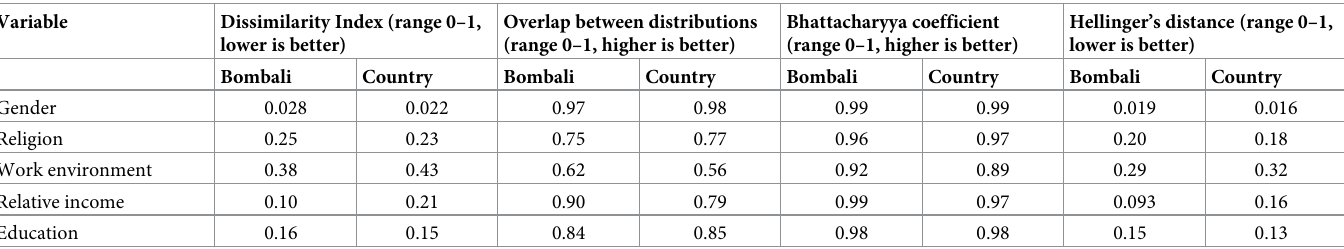
Table 4. Results of marginal distributions of categorical variables. Variable Dissimilarity Index (range 0–1, Overlap between distributions lower is better) (range 0–1, higher is